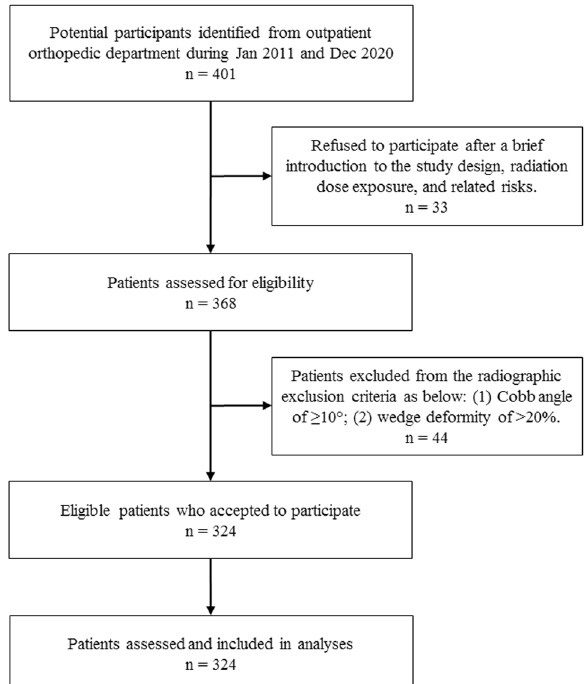
Figure 4. Flowchart of the study.